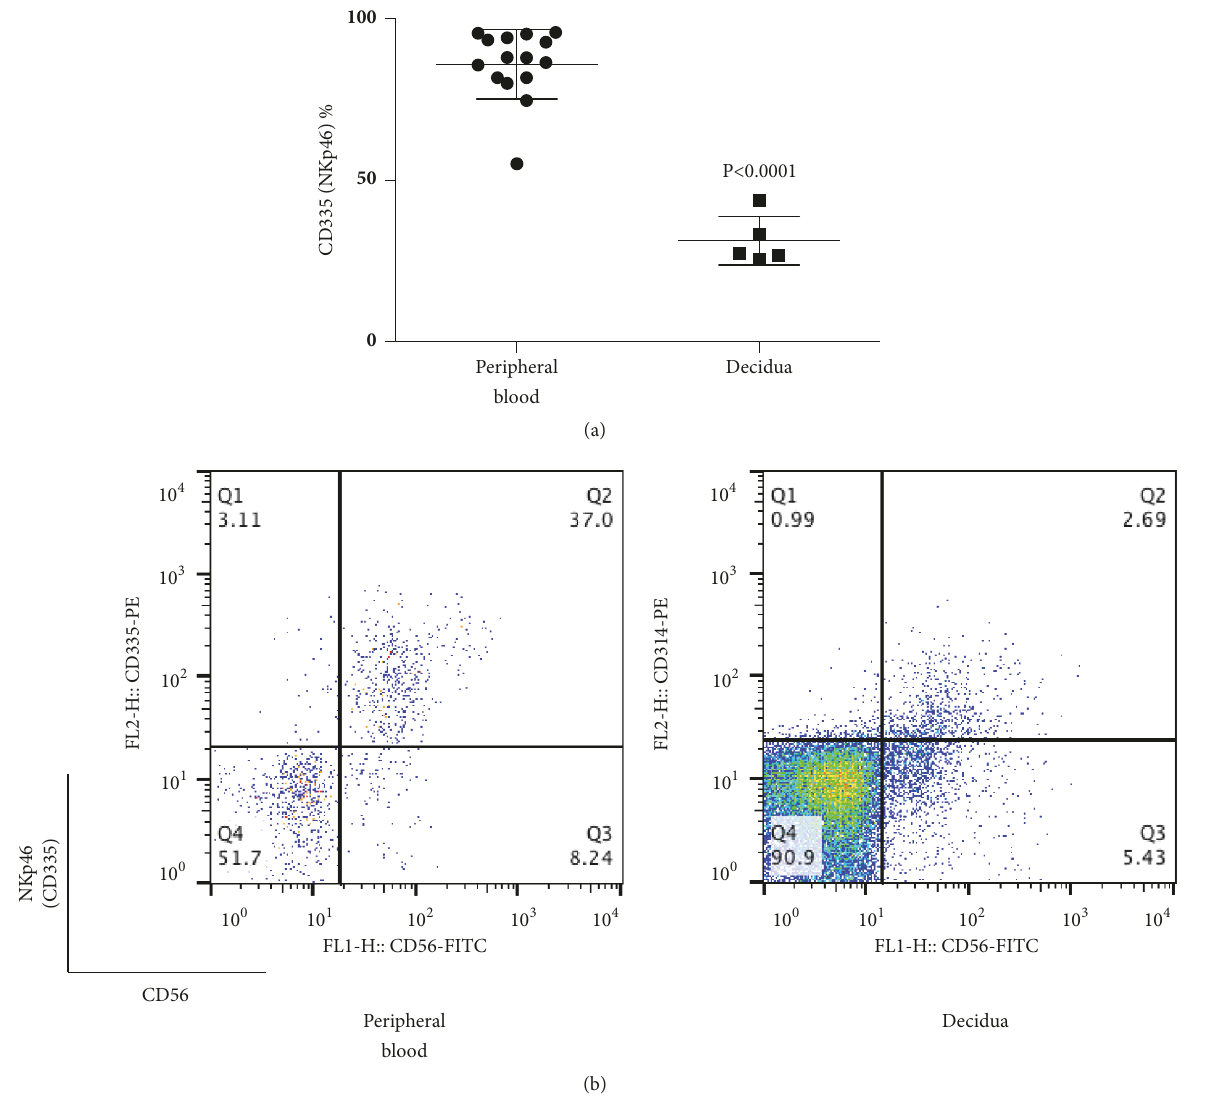
Figure 4: (a) Percentage of CD335 (NKp46)+ cells among CD56+CD3 − cells at term pregnancy in peripheral blood and decidua. The percentage of CD335 (NKp46)+ lymphocytes in decidua was lower than in peripheral blood. (b) Representative dot plot analysis of CD335 (NKp46)+ cells among CD56+CD3- lymphocytes taken from term pregnancy by flow cytometry. The gate was set around the CD3- lymphocytes to analyze the CD335+CD56+ NK